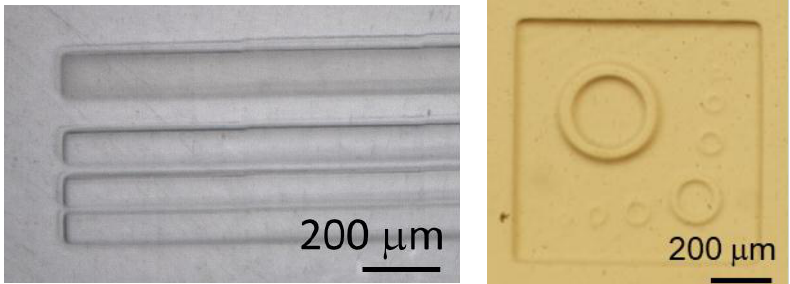
Figure 5. Swollen microfabricated hydroxypropyl cellulose (HPC) hydrogel produced by focused proton microbeam.